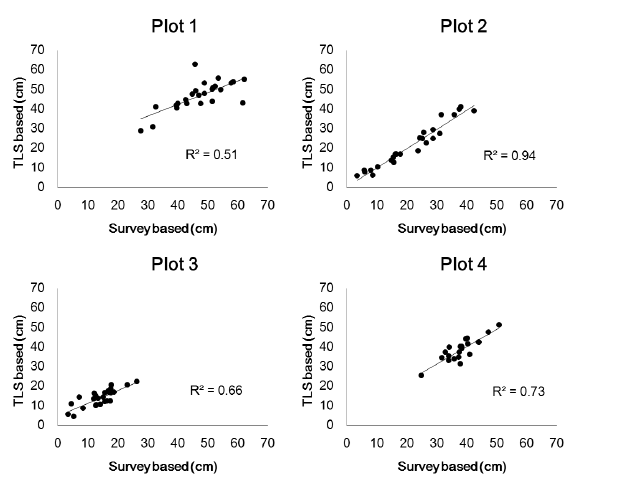
Figure 7. Comparison of water depth derived by TLS and